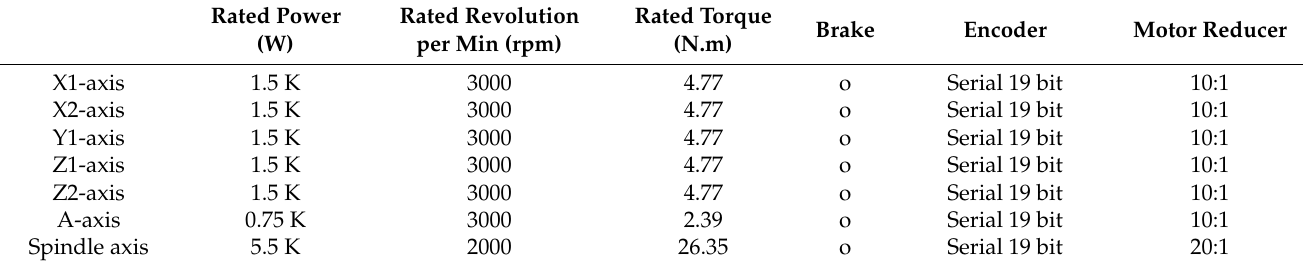
Table 2. Specification of servo